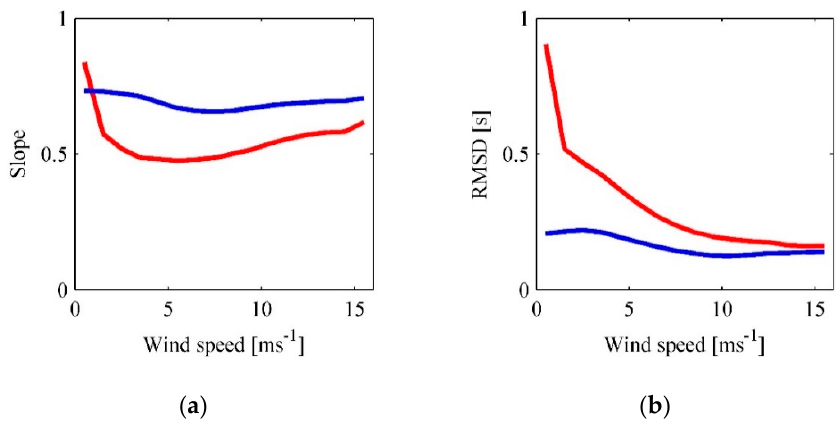
Figure 11. ( a ) Slope of the regression lines of T B a (blue) and T CB a (red) for 16 data subsets; ( b ) RMSD around the regression lines of T B a (blue) and T CB a (red) for 16 data